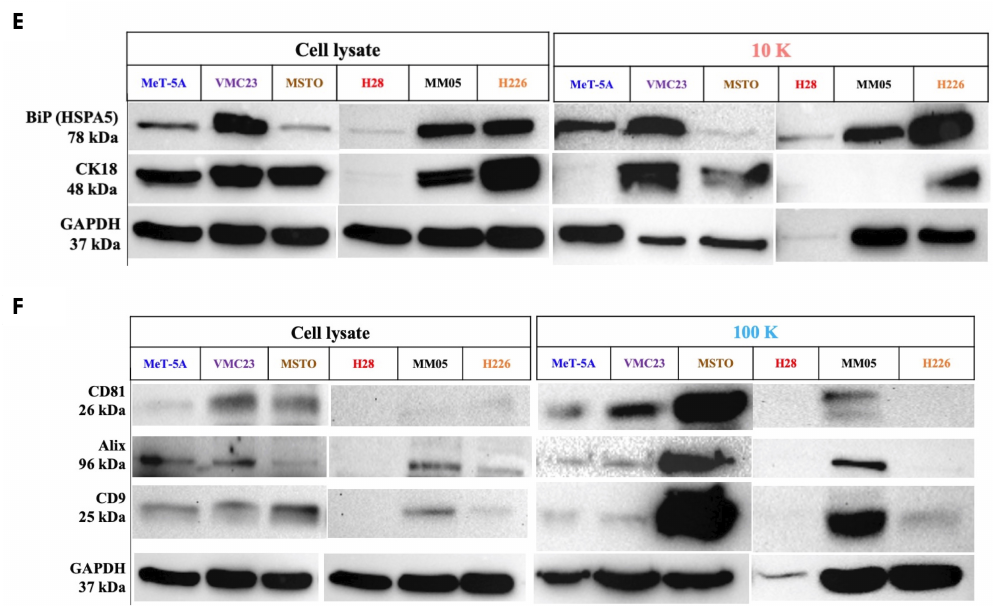
Figure 3. Characterization of EV types. Flow cytometry showing number of gated, phosphatidyl- serine-positive events in ( A , C ) 18 K pellets and ( B , D ) 10 K EV pellets. ( E ) Western blot with indicated antibodies, showing CK18 and HSPA5 in the 10 K pellets, and ( F ) CD81, CD9, and ALIX in the 100 K pellets. GAPDH was loaded as a control. Original blot see Supplementary File